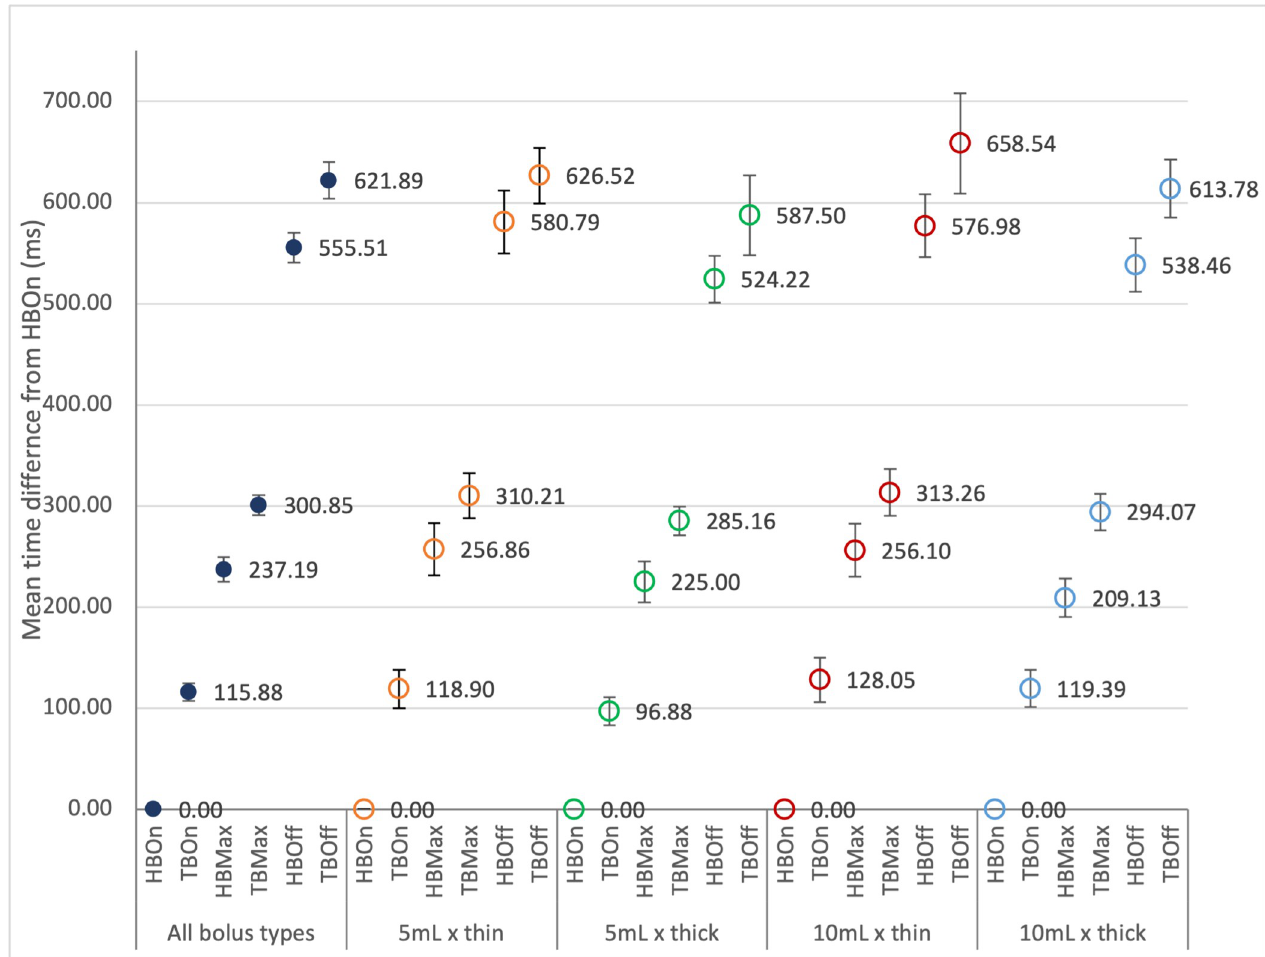
Fig 4. Graphical presentation of mean time difference (in ms) from the onset of hyoid bone excursion ( HBOn ) for different events when swallowing different bolus types. Note : TBOn = Displacement onset of tongue base retraction, TBMax = Maximum displacement of tongue base retraction, TBOff = Displacement offset of tongue base retraction, HBOn = Displacement onset of hyoid bone excursion, HBMax = Maximum displacement of hyoid bone excursion, HBOff = Displacement offset of hyoid bone excursion, Error bars represent 95% confidence intervals.